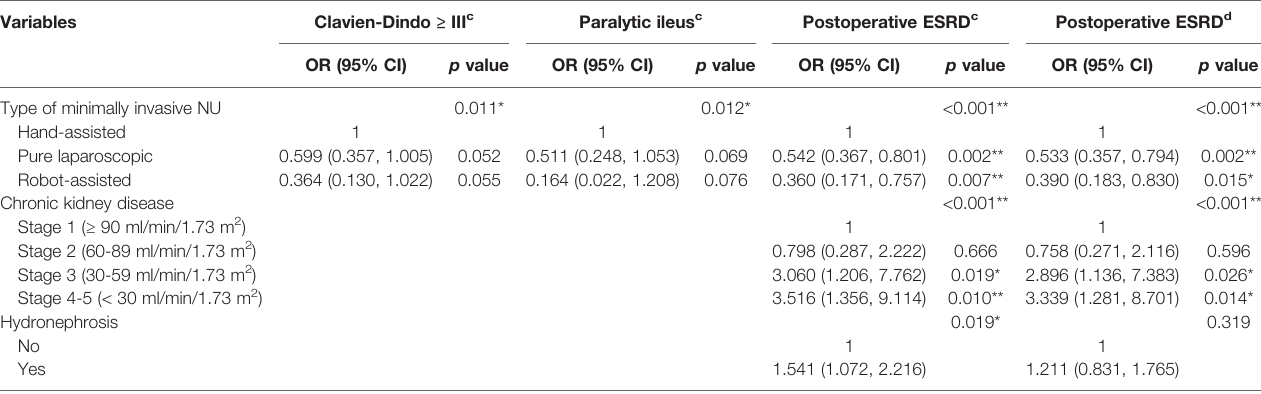
TABLE 4 | Comparative univariate/multivariate logistic regression analysis for postoperative complications.